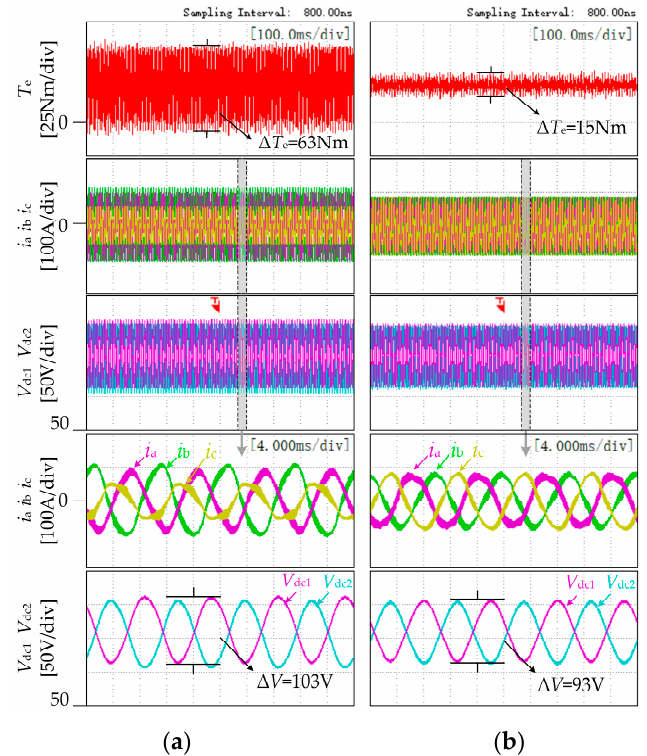
Figure 10 . Experimental results at 1500 r/min and 30 Nm: ( a ) without capacitor voltage offset suppression; ( b ) proposed method .